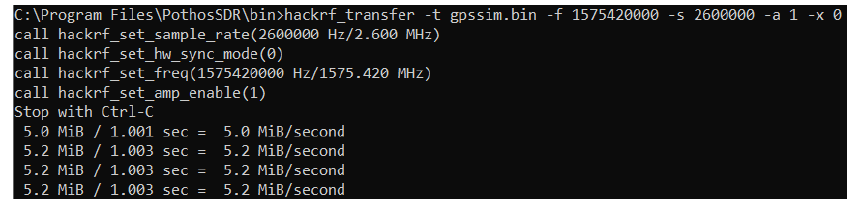
Figure 6. Command used to transfer the binary file to the HackRF One